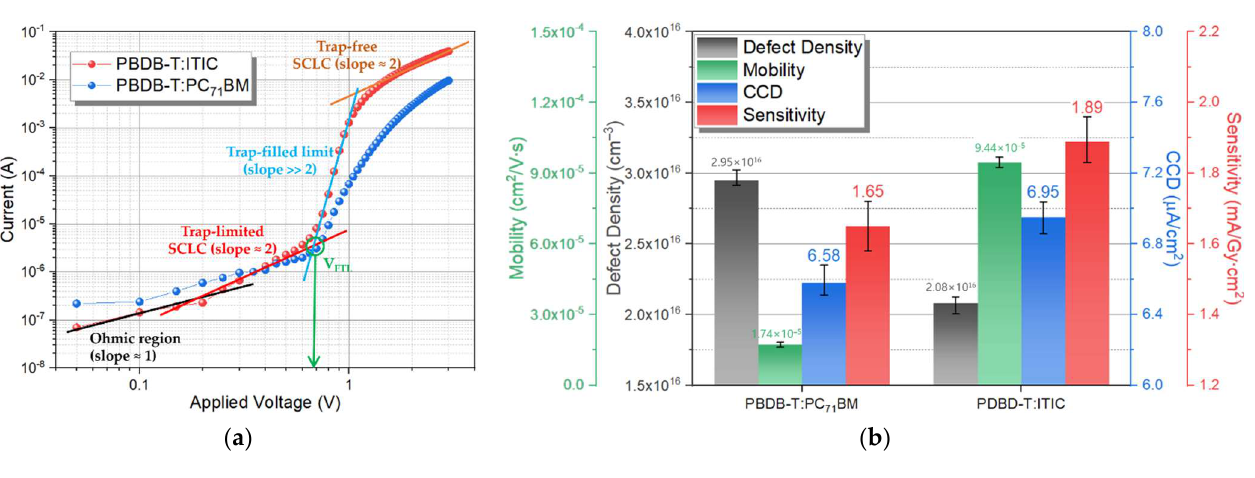
Figure 7. ( a ) Curve fitting of the logarithmic J–V characteristics, and ( b ) the mobilities, defect densities, CCD, and sensitivity of the as-prepared detector with the different acceptors under the dark condition.